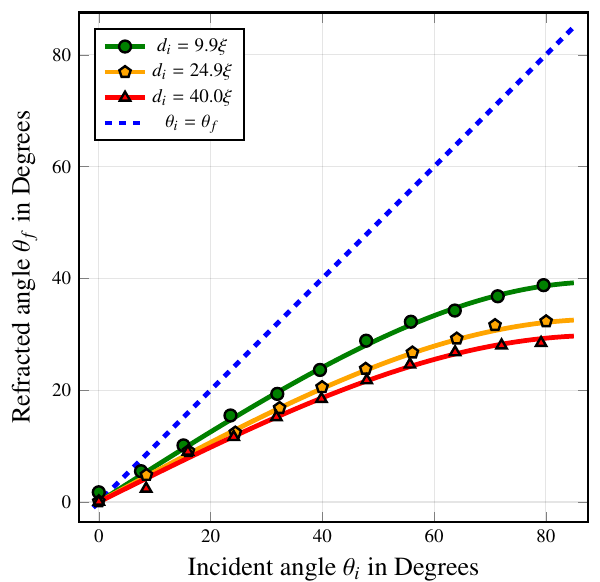
/ρ = 10 / 8.5) with low Figure 7: Incident vs refracted angle across the large step ( ρ 1 2 = 9.9 ξ ), medium ( d = 24.9 ξ ) and high ( d = 40.0 ξ ) energy dipoles. Data points ( d i i i on the dashed blue line represent a dipole undergoing total internal reflection, with the incident angle equal to the refracted angle. The solid lines are the predictions of Eq. (19a) for each initial dipole separation